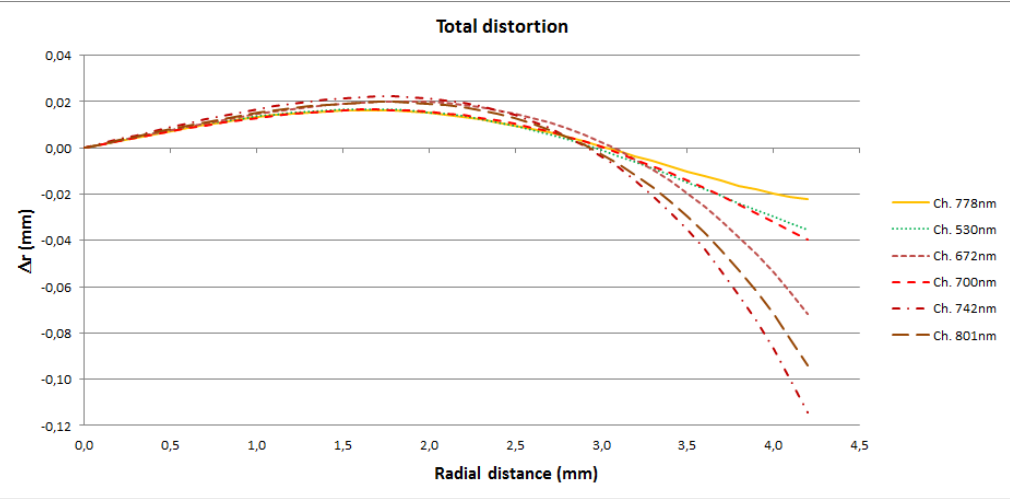
Figure 6. Graphic representation of geometric distortion of the six channels of the